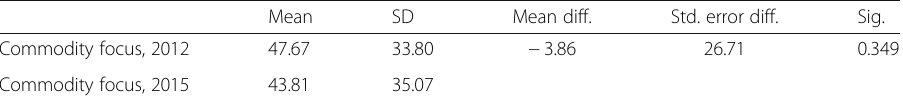
Table 4 Change in commodity focus, 2012 – 2015 ( n =